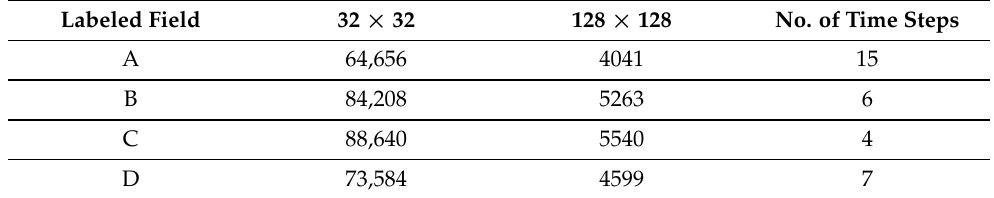
Table 7. Weak labeled data for each parsley field for 32 × 32 and 128 × 128 pixel size images per time step.